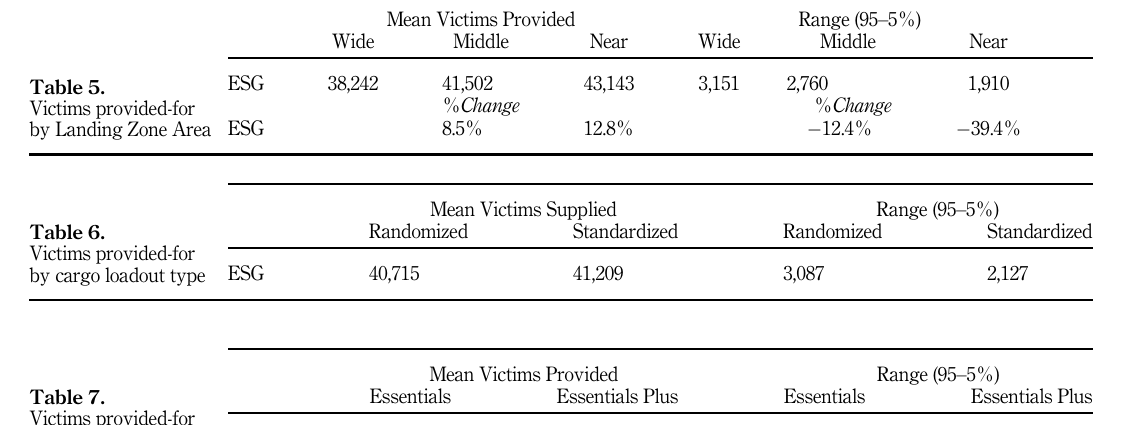
Table 7. Victims provided-for by response